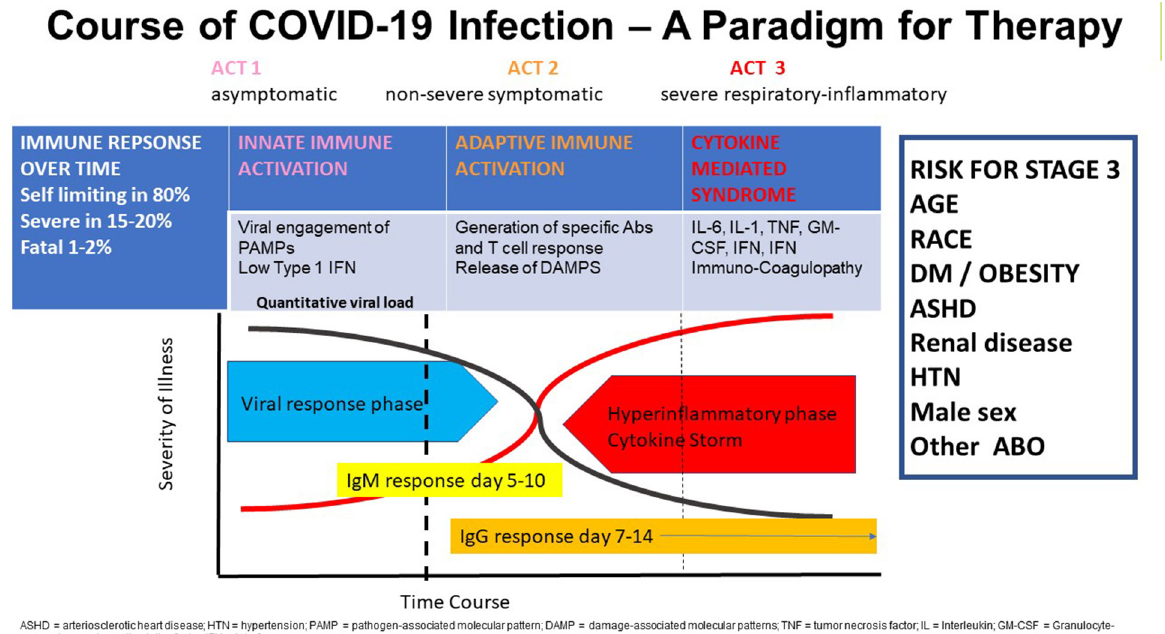
Figure 2. Summary of the 3 phases of COVID-19 immune response and disease progression over time. Immune response against SARS-CoV-2 infection proceeds through 3 general phases. Phase 1 is that of asymptomatic innate immune activation initiated by entry of SARS-CoV-2 into host cells of the upper respiratory track with triggering of innate immunity including the interferon response. The virus appears to antagonize initial viral detection and interferon by yet unknown mechanisms [33]. Failing to contain the infection Phase 2 is marked by activation of adaptive immune response with production of specific IgM followed by IgG antibodies as well as T-cell activation including CD4 and CD8 responses but not marked by hyperinflammation. Clinical resolution generally occurs over 10-14 days in the majority of patients. In a minority of patients often accompanied by one or more of numerous comorbid conditions (shown on left) or genetic risk factors [34], which largely remain poorly defined, a third phase ensues characterized by hyperinflammation, lymphopenia, immunothrombosis, and end organ damage especially in the lungs in about 15%-20% of